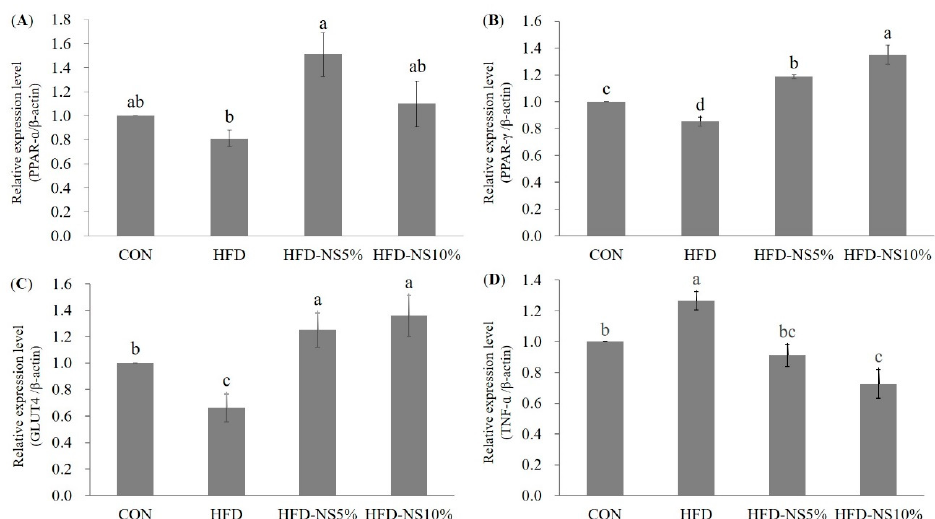
Figure 5. Effects of Nelumbinis Semen powder on protein expression in C57BL/6 mice fed a normal diet (CON), high-fat diet (HFD), high-fat diet with 5% Nelumbinis Semen powder (HFD-NS5%), and high-fat diet with 10% Nelumbinis Semen powder (HFD-NS10%) ( n = 8/group). ( A ) Relative expression level of PPAR- α / β -actin. ( B ) Relative expression level of PPAR- γ / β -actin. ( C ) Relative expression level of GLUT4 / β -actin. ( D ) Relative expression level of TNF- α / β -actin. a–d The different letters represent significant differences at p < 0.05 by Duncan’s multiple range test.